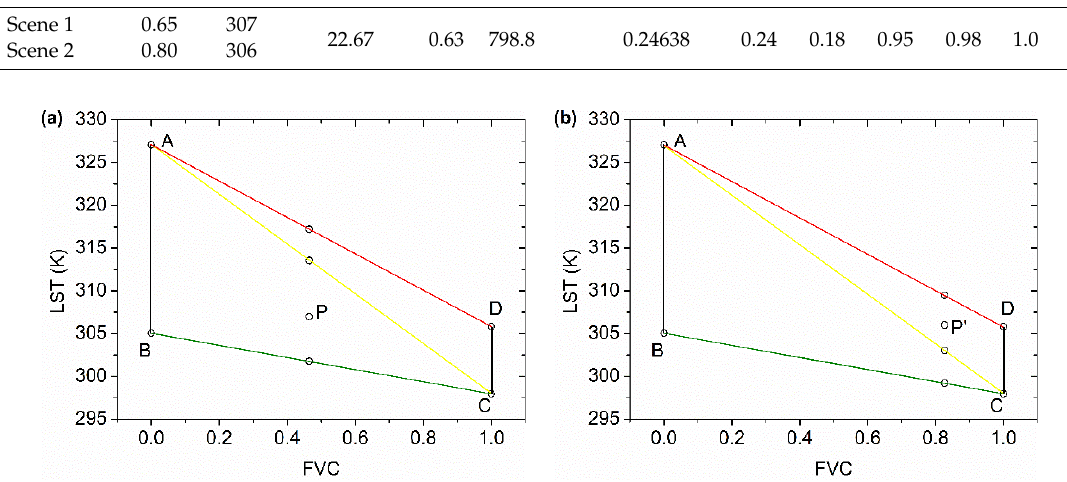
Figure 6. The two-stage trapezoidal LST/FVC spaces corresponded to different scenes where ( a ) corresponds to the Scene 1 and ( b ) corresponds to Scene 2.